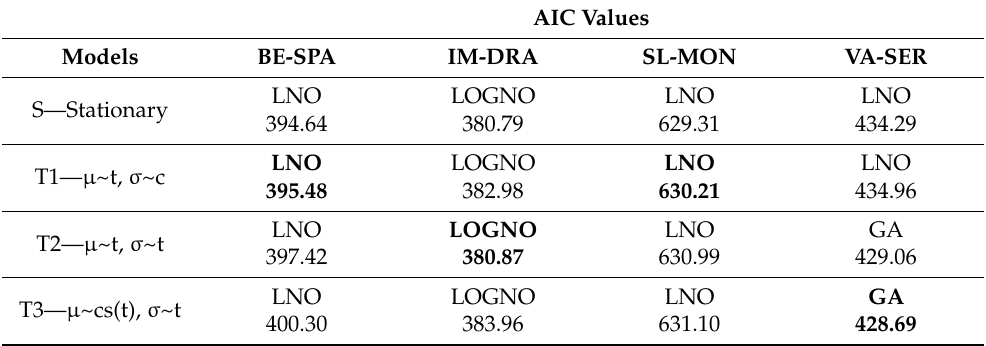
Table 4. Comparison of the stationary and non-stationary best models with time as covariate. In bold are shown those models which provided the lowest AIC values among the non-stationary